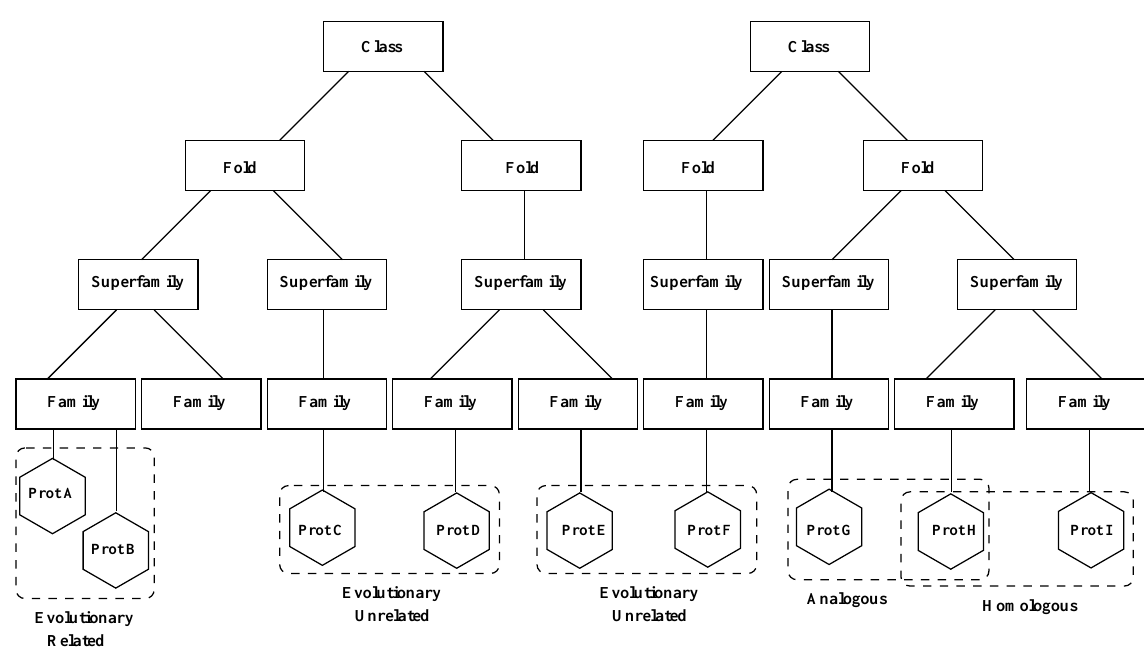
Figure 1: Schematic diagram of the SCOP hierarchical classification of proteins and the selection of evolutionarily related, unrelated, homologous and analogous proteins for the two classification problems considered in this